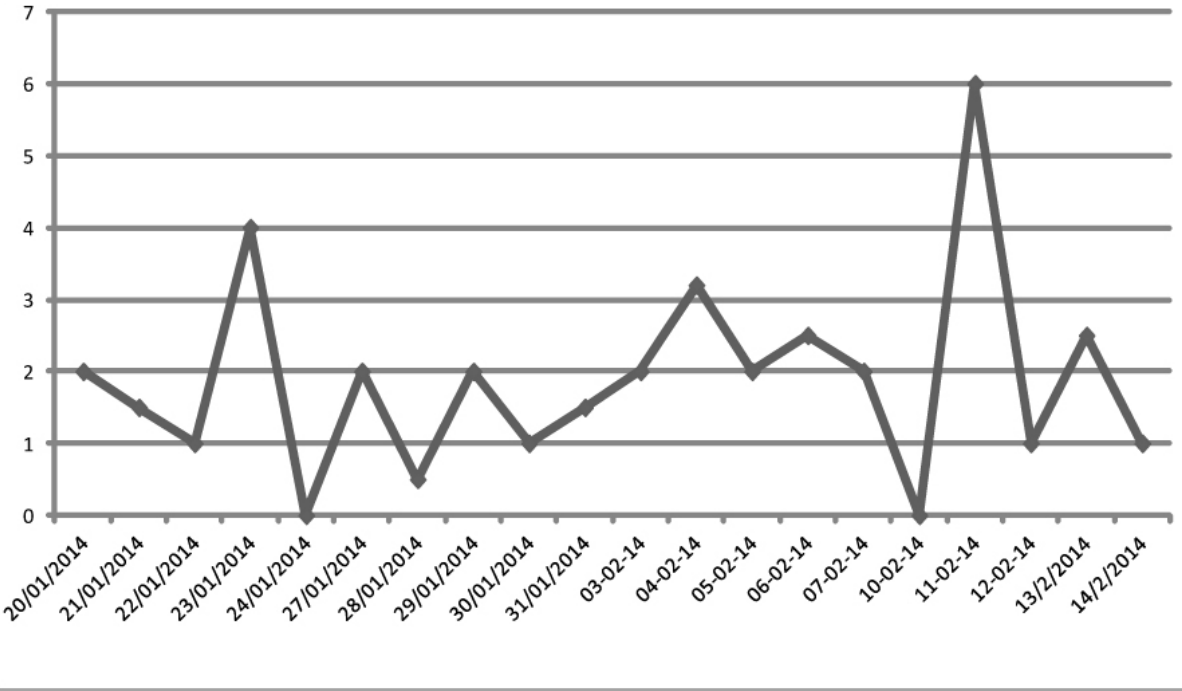
were currently using the system were 8 times more likely to